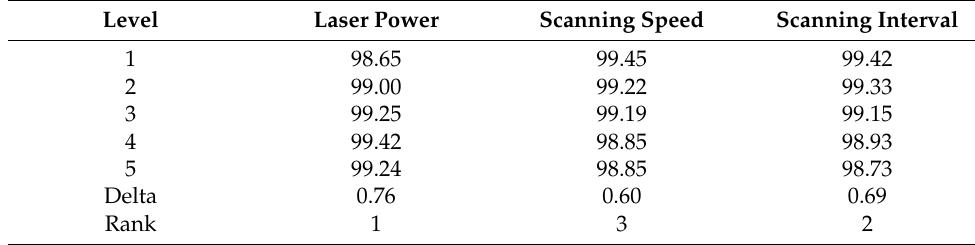
Table 4. Mean response table for relative density.